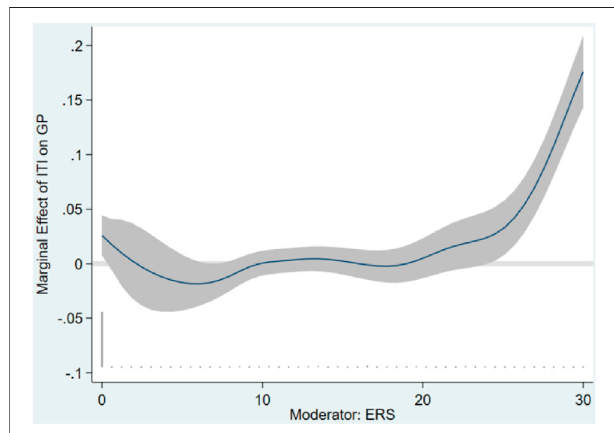
FIGURE 2 | Effects of state ownership.